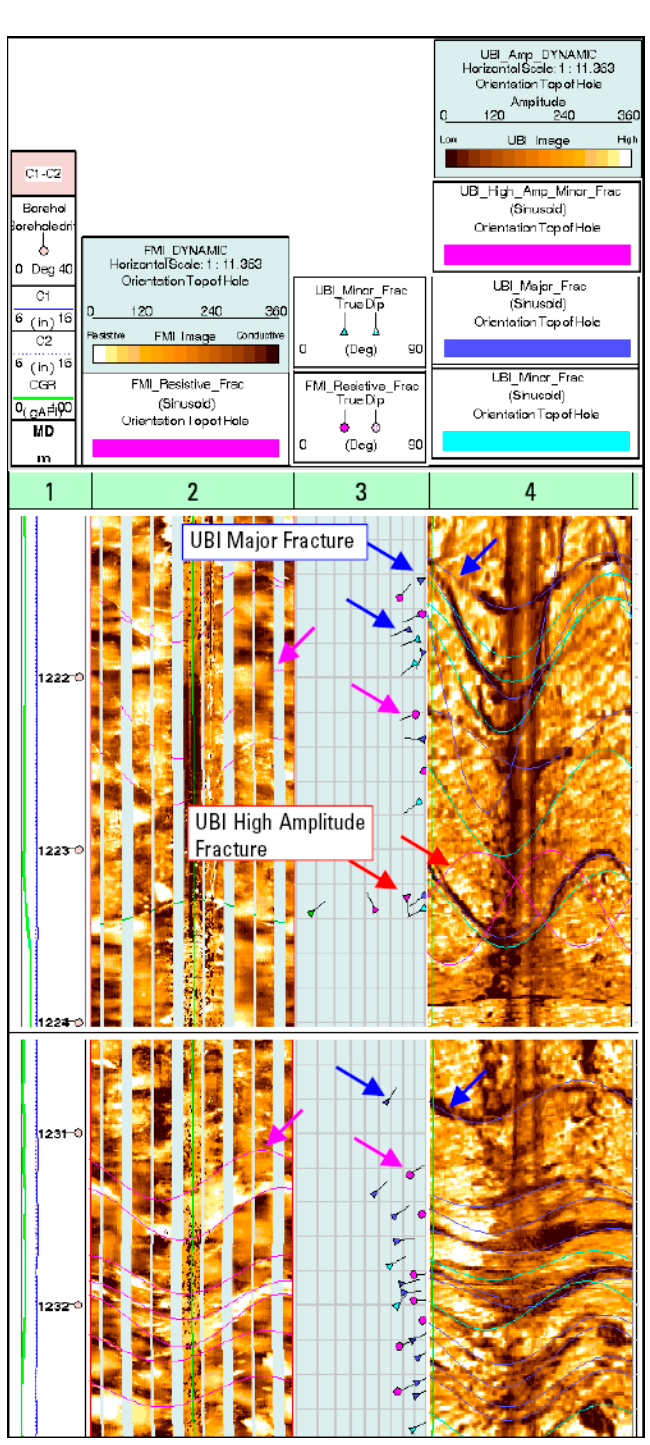
Figure 11. Two highly fractured zones in Sarvak I interval on UBI logs.